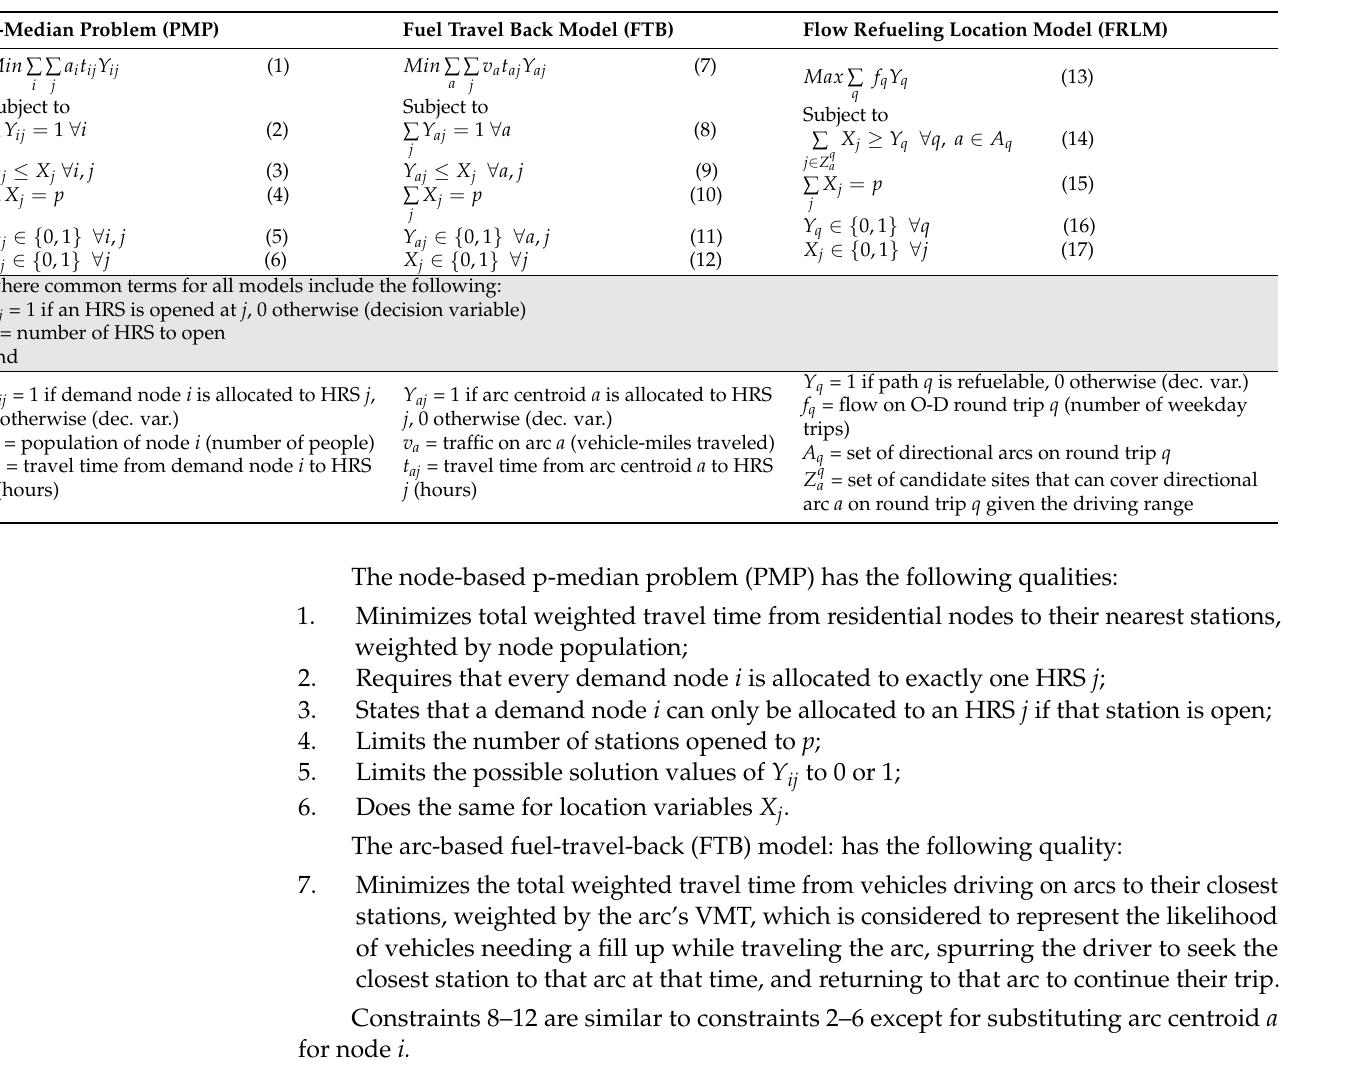
Table 4. HRS optimization model